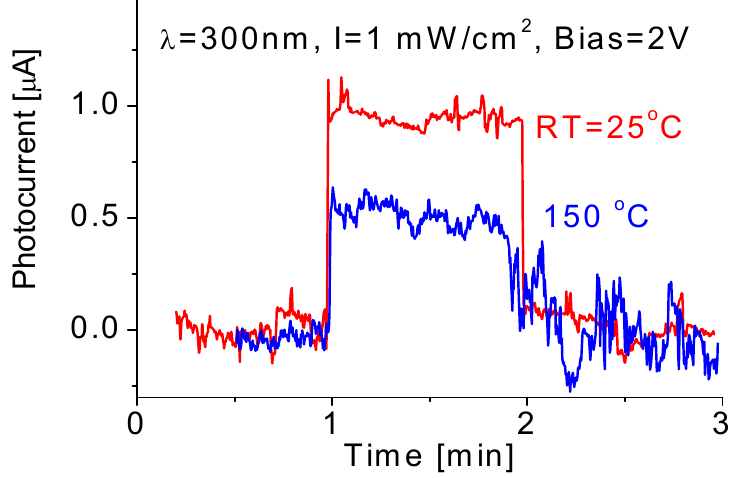
Figure 8. Thermal e ff ect on the responses of the prototypic DUV-PD to 1 mW / cm 2 Figure 8. Thermal effect on the responses of the prototypic DUV ‐ PD to 1 mW/cm 2 .